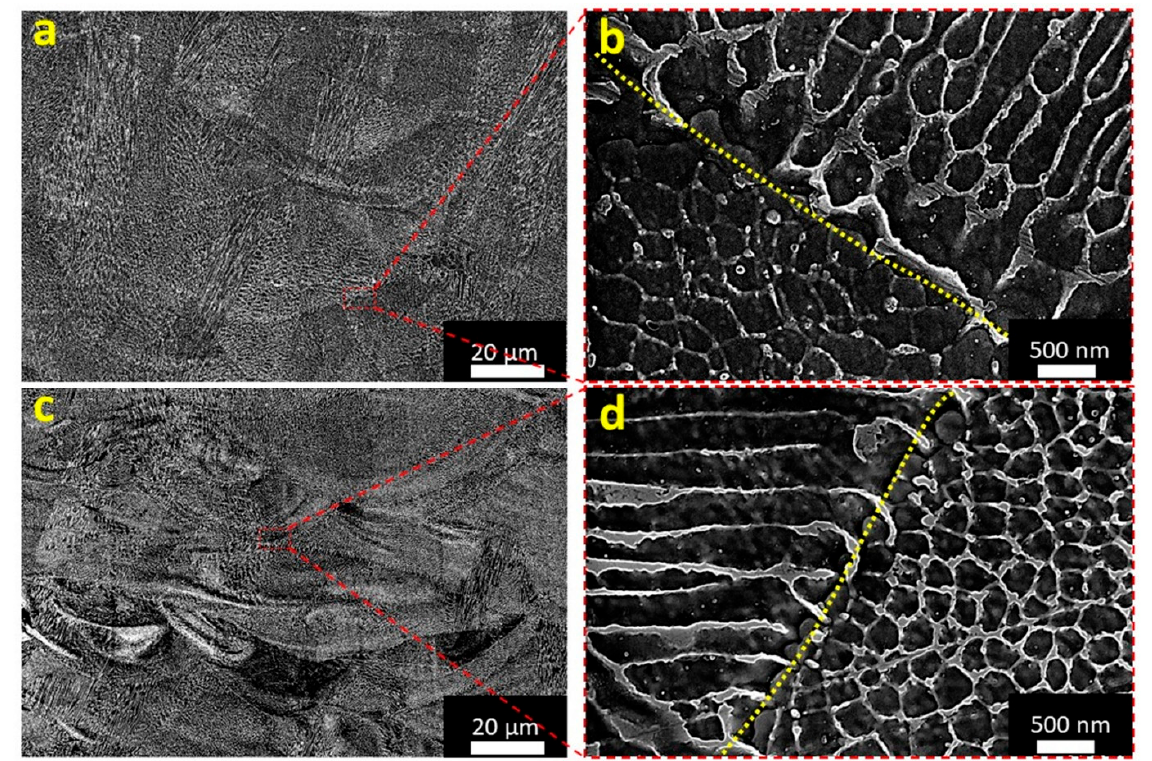
Figure 4. SEM images of the AB IN625 ( a , b ) and AB IN625mod ( c , d ), showing the fine dendritic structures. The yellow line indicated the melt pool contours for the high magnification images.